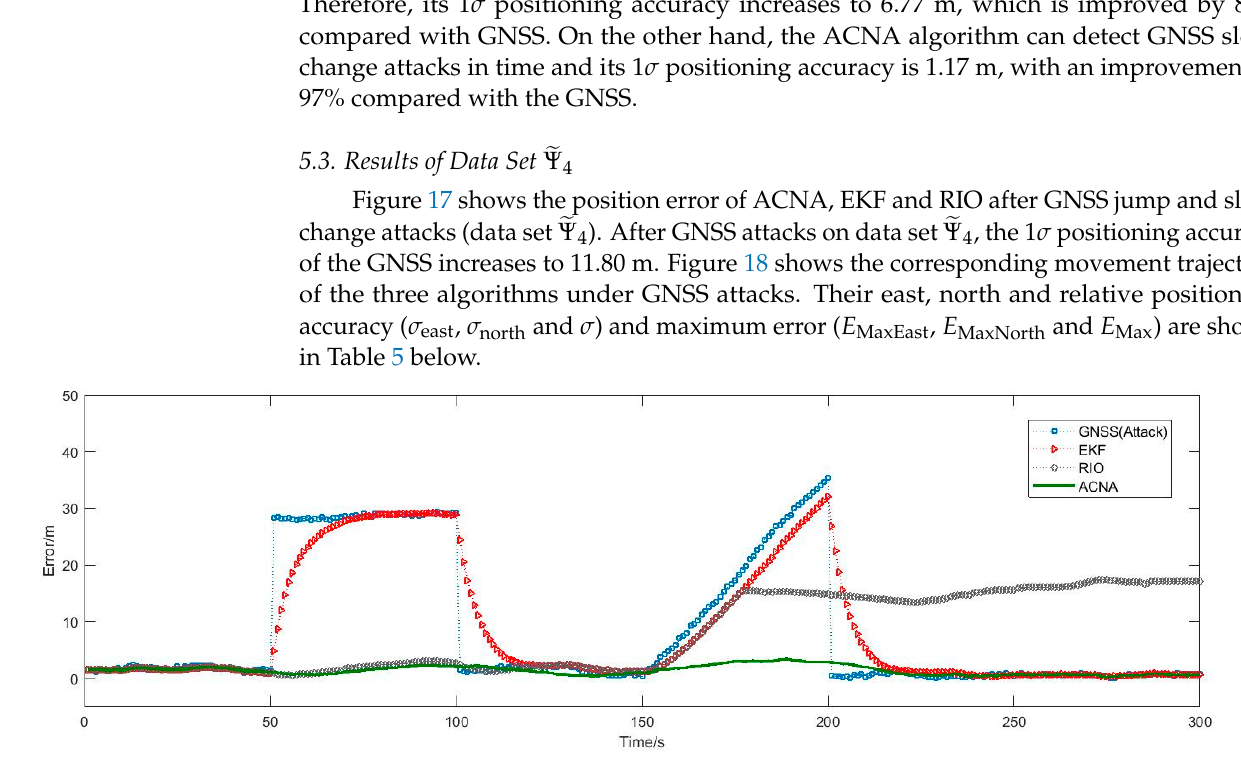
Figure 17. The position error of the three algorithms on data set (cid:101) Ψ 4 .